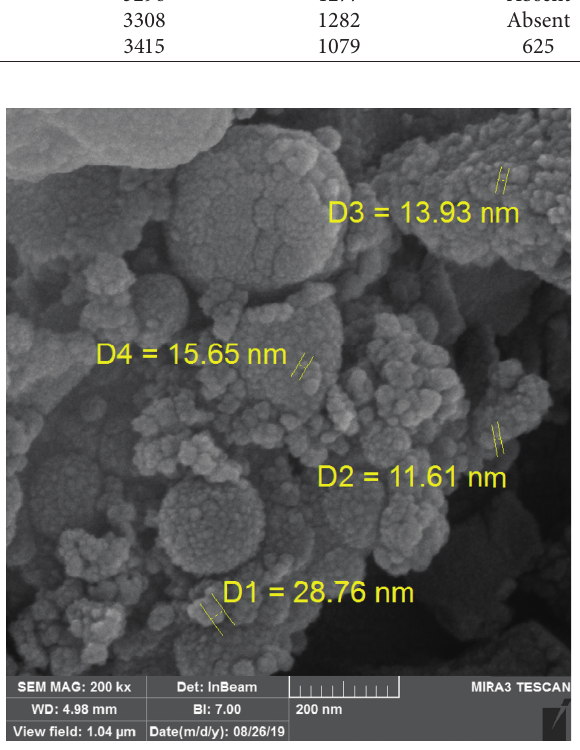
Figure 4: FESEM image of the new nanoscale Cu (II) Schiff base